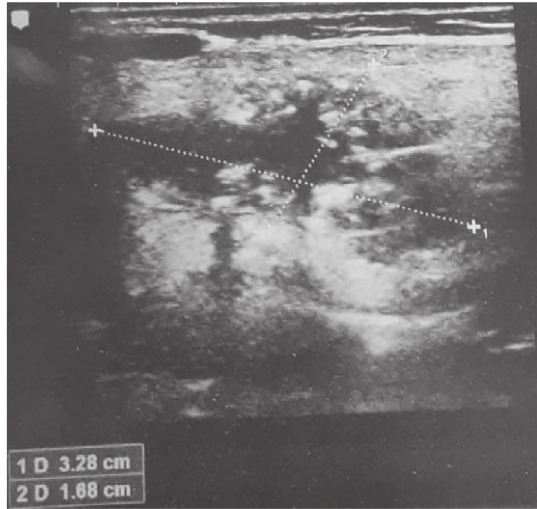
Figure 2: Picture showing ultrasound imaging, suggestive of ar- teriovenous